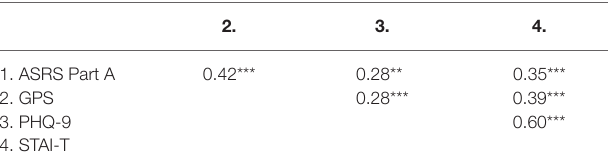
TABLE 2 | Correlations among all